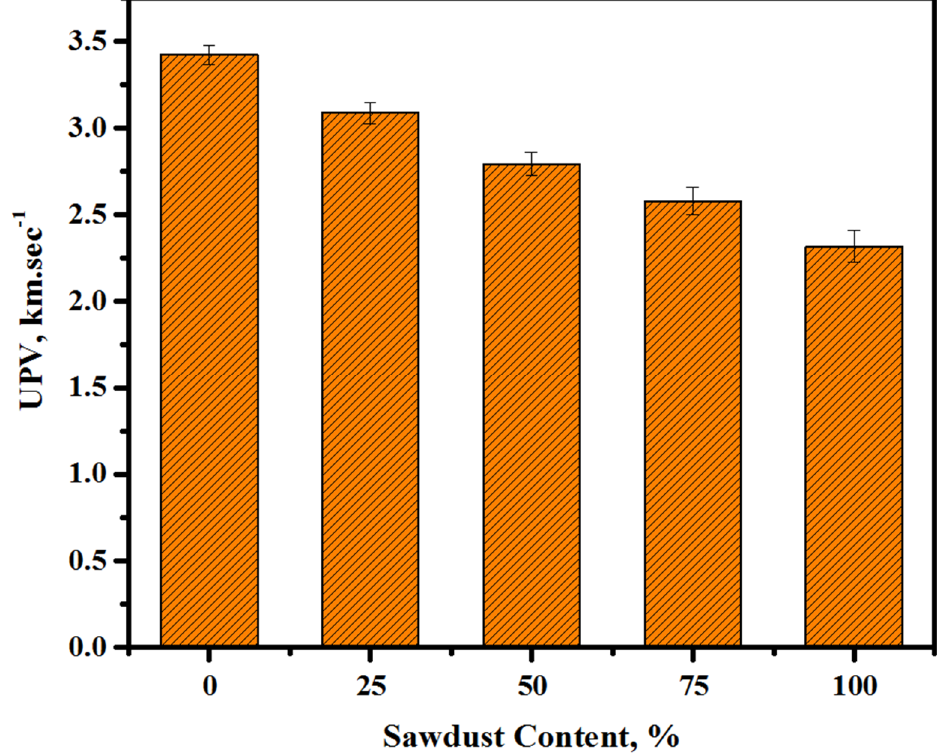
Figure 8. UPV readings of the prepared concretes with various sawdust contents at 28 days of age.